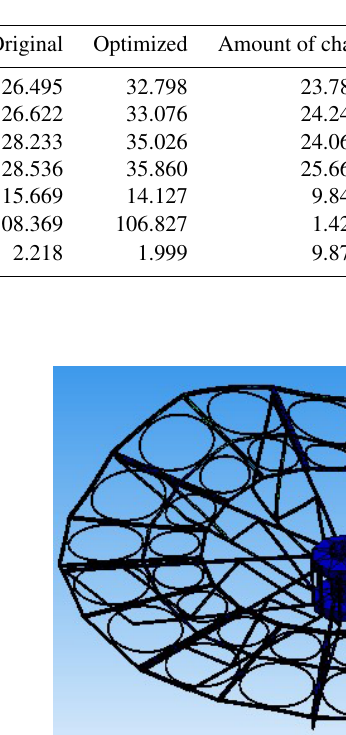
Figure 19. Variations of the mass value under different numbers of generation.